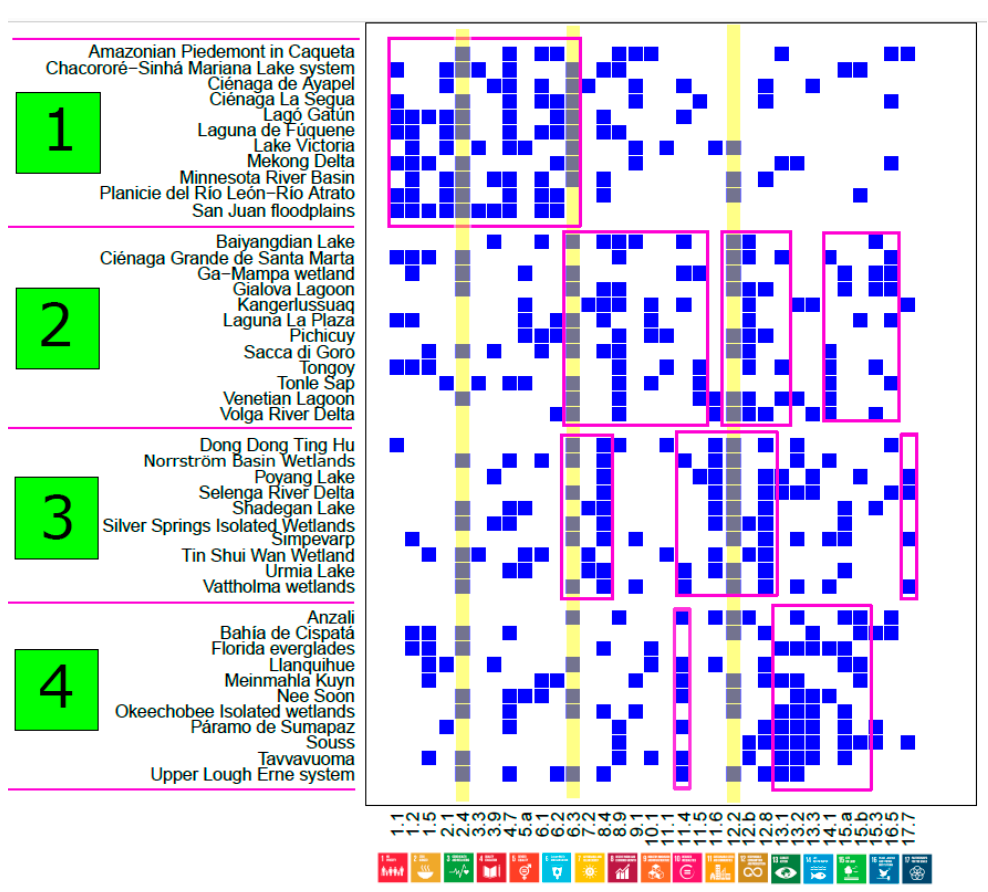
Figure 7. Bundles of both Sustainable Development Goals (SDG) targets (x-axis) and wetlandscapes (y-axis) based on the bimodal network of targets and wetlandscapes. For each wetlandscape, the ten priority SDG targets are shown (blue small squares). The four resulting bundles (green-box numbers) for wetlandscape management are: (1) “Basic human needs”, (2) “Sustainable tourism”, (3) “Environmental impact in urban wetlands”, and (4) “Improving and conserving environment”. The relationships making the bundles unique are shown within the pink rectangles. The three most common priority targets across surveys are highlighted in yellow (See Figure 3).